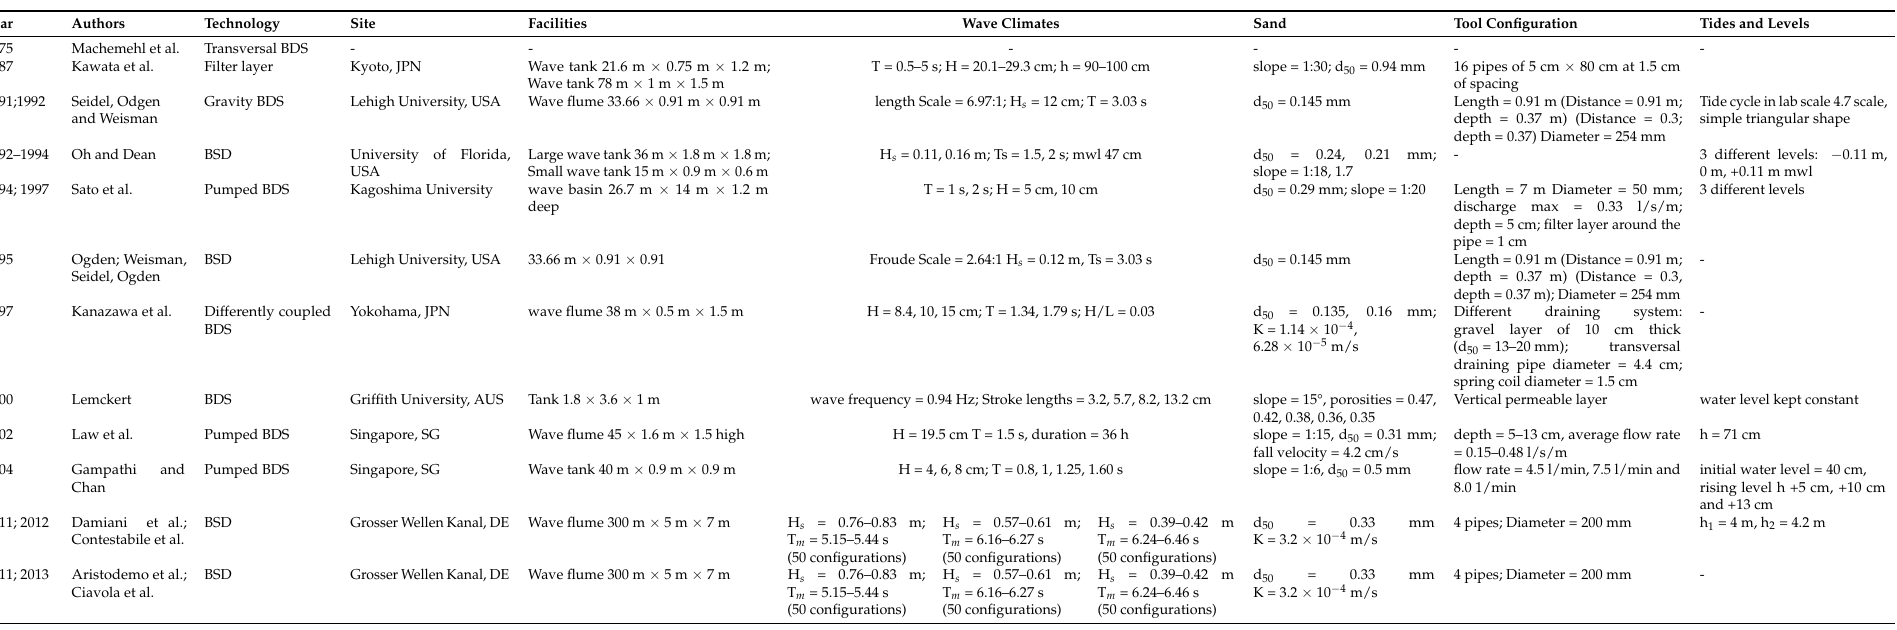
Table 1. Overview of the laboratory experiences. In the table, d 50 is the mean diameter of the sand, T m is the mean period; T is the wave period; H s is the significative wave height; H is the waves height; h is the water depth; K is the sand permeability; H/L is the wave height-length